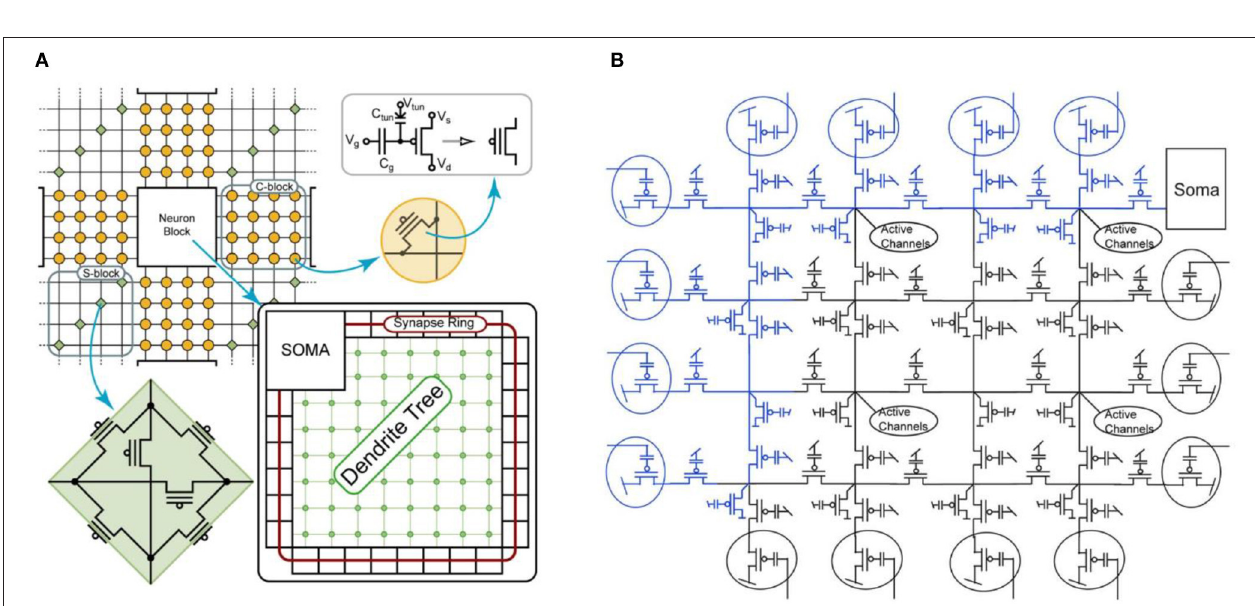
FIGURE 27 | Optimal path planning originally demonstrated on the IC in Figure 26 . (A) Grid environment example that the neuron IC solved. The device is located at Node 22, and the goal is at Node 77. A wavefront in initiated at the goal (Node 77) and propagated throughout the neuron grid. (B) Raster plot of the solution nodes. Neuron 77 causes neuron 76 to fire, which causes neuron 75 to fire, etc.